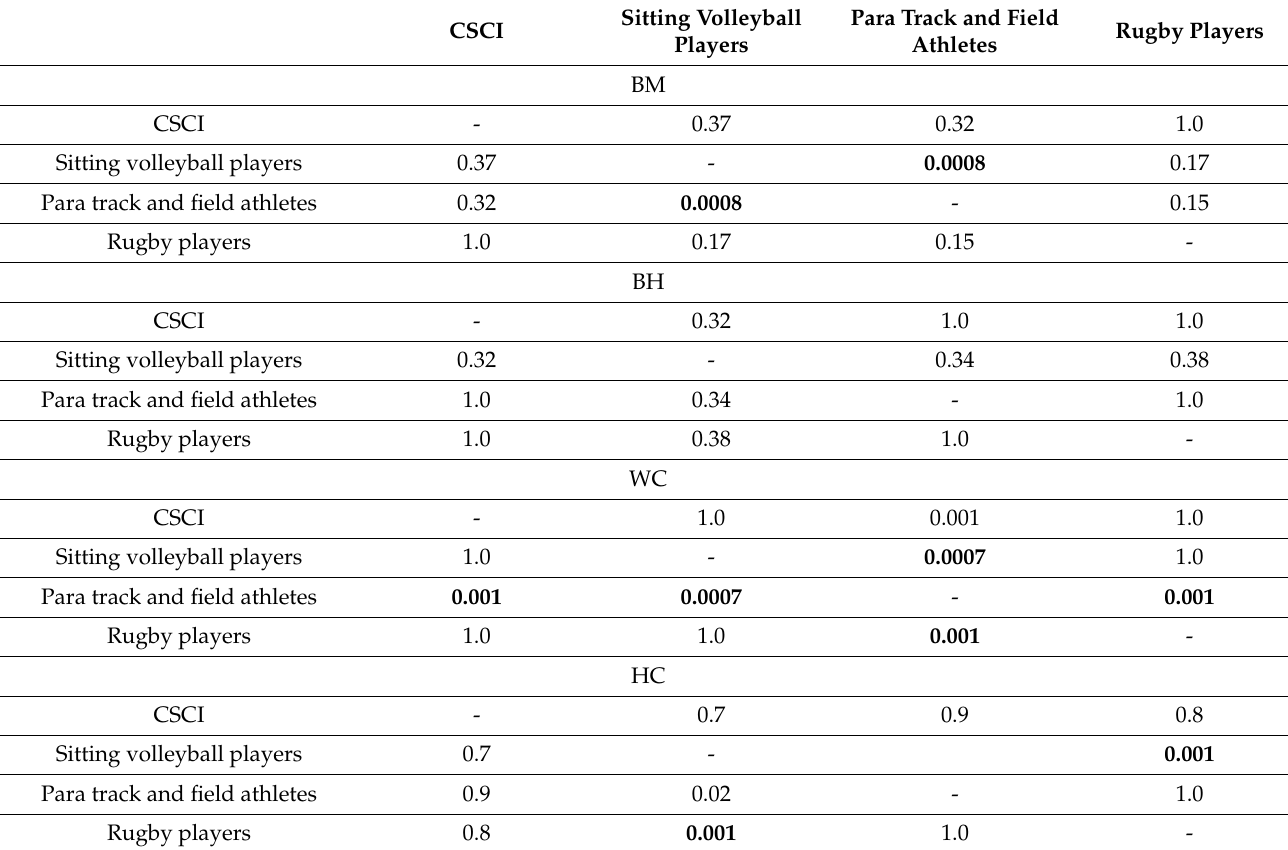
Table 2. Post hoc test for multiple comparisons of anthropometric characteristics.